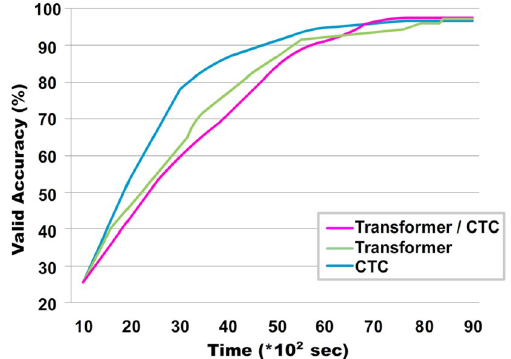
Figure 4. Comparing curves when training a model on Read speech.